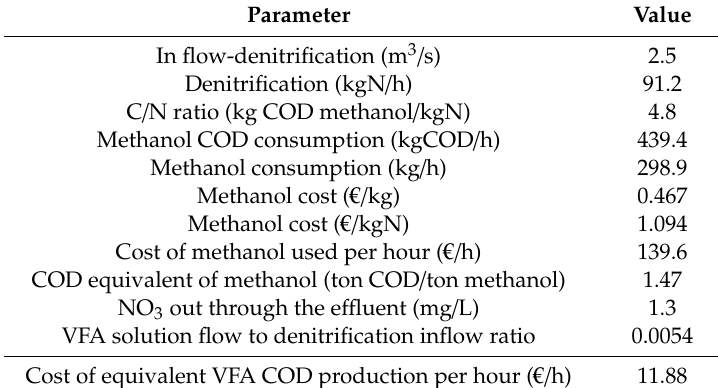
Table 3. The base processing conditions taken into account for the denitrification stage.